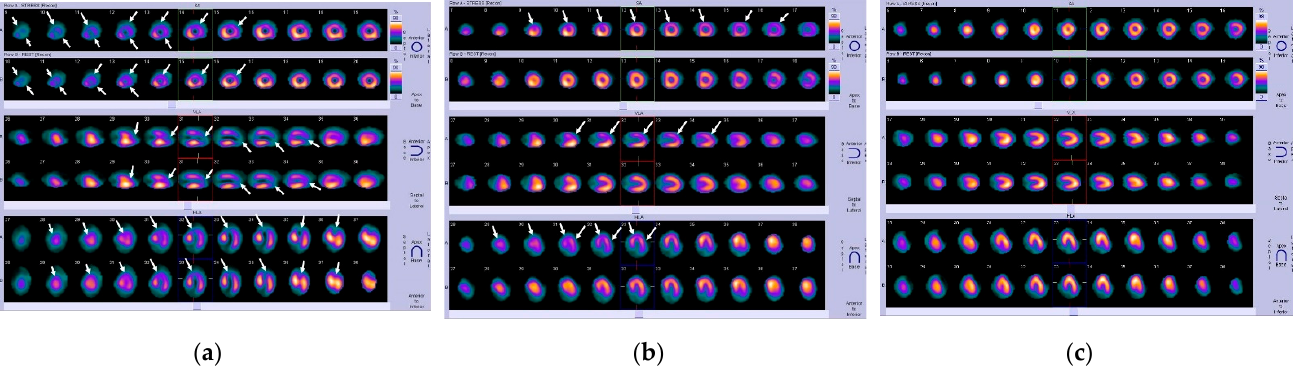
Figure 1. Original SPECT MPI samples of coronary artery disease produced by Siemens camera: ( a ) infarction; ( b ) ischemia; ( c ) normal.